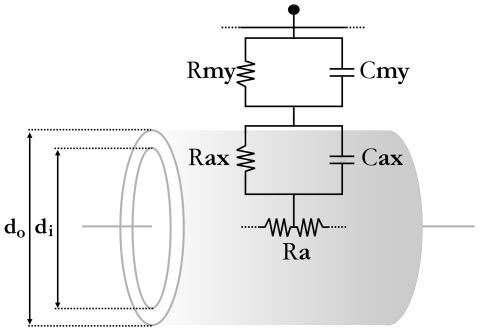
Geometrical and electrical properties of a myelinated axon internodal segment of unit length and a schematic of the equivalent circuit.
di and do represent the inner and outer (i.e., di + total myelin sheath thickness) axon diameters respectively. Rm and Cm used in the model can be related to the axolemma (ax) and myelin (my) electrical components as follows: Rm = Rax+nRmy and 1/Cm = 1/Cax+n/Cmy, where n is the number of myelin lamellae with a periodicity of 16 nm (naïve). Ra depends on both the geometric properties of the inner core and the core resistivity (p). Axon electrical parameters; p = 70 Ω·cm, Rax = 4.7×103 Ω·cm2, Rmy = 800 Ω·cm2 (per lamellae), Cax = 1 µF/cm2, Cmy = 0.6 µF/cm2 (per lamellae). All values are based on published work (see [30], [59]–[62] and text).